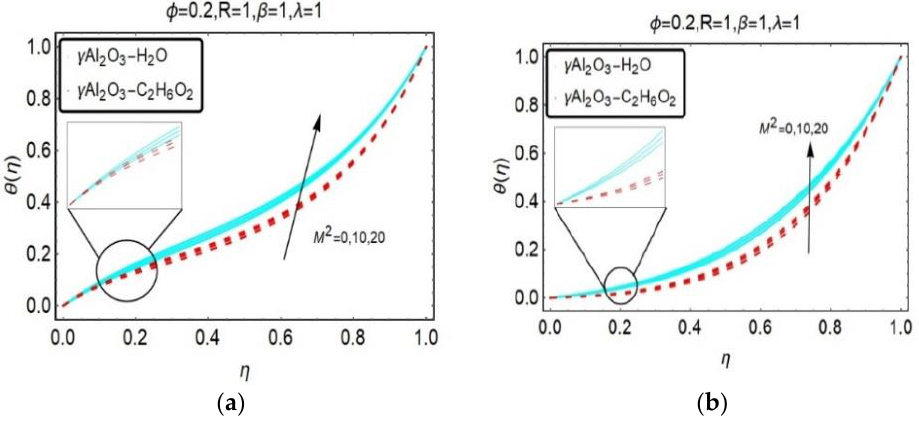
Figure 17. Influence of 𝛽 on 𝜃(𝜂) for ( a ) 𝑆 > 0 and ( b ) 𝑆 < 0 . Energies 2020 , 13 , x FOR PEER REVIEW